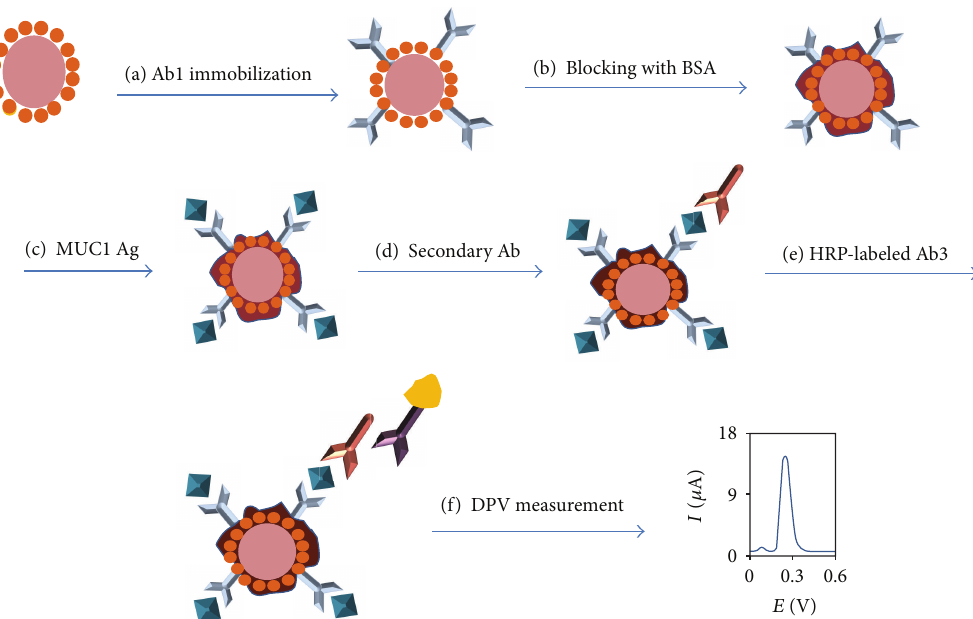
Figure 1: Sandwich immunosensor preparation for MUC1 detection: (a) primary antibody attachment on MBs surface; (b) MBs free binding- sites blocking using BSA; (c) incubation with MUC1 antigen solutions and Ab1/MUC1 Ag complex formation on the MBs; (d) reaction with Ab2, (e) incubation with Ab3 labeled with HRP; (f) DPV measurements of MBs-bound MUC1 in presence of acetaminophen/H 2 O 2